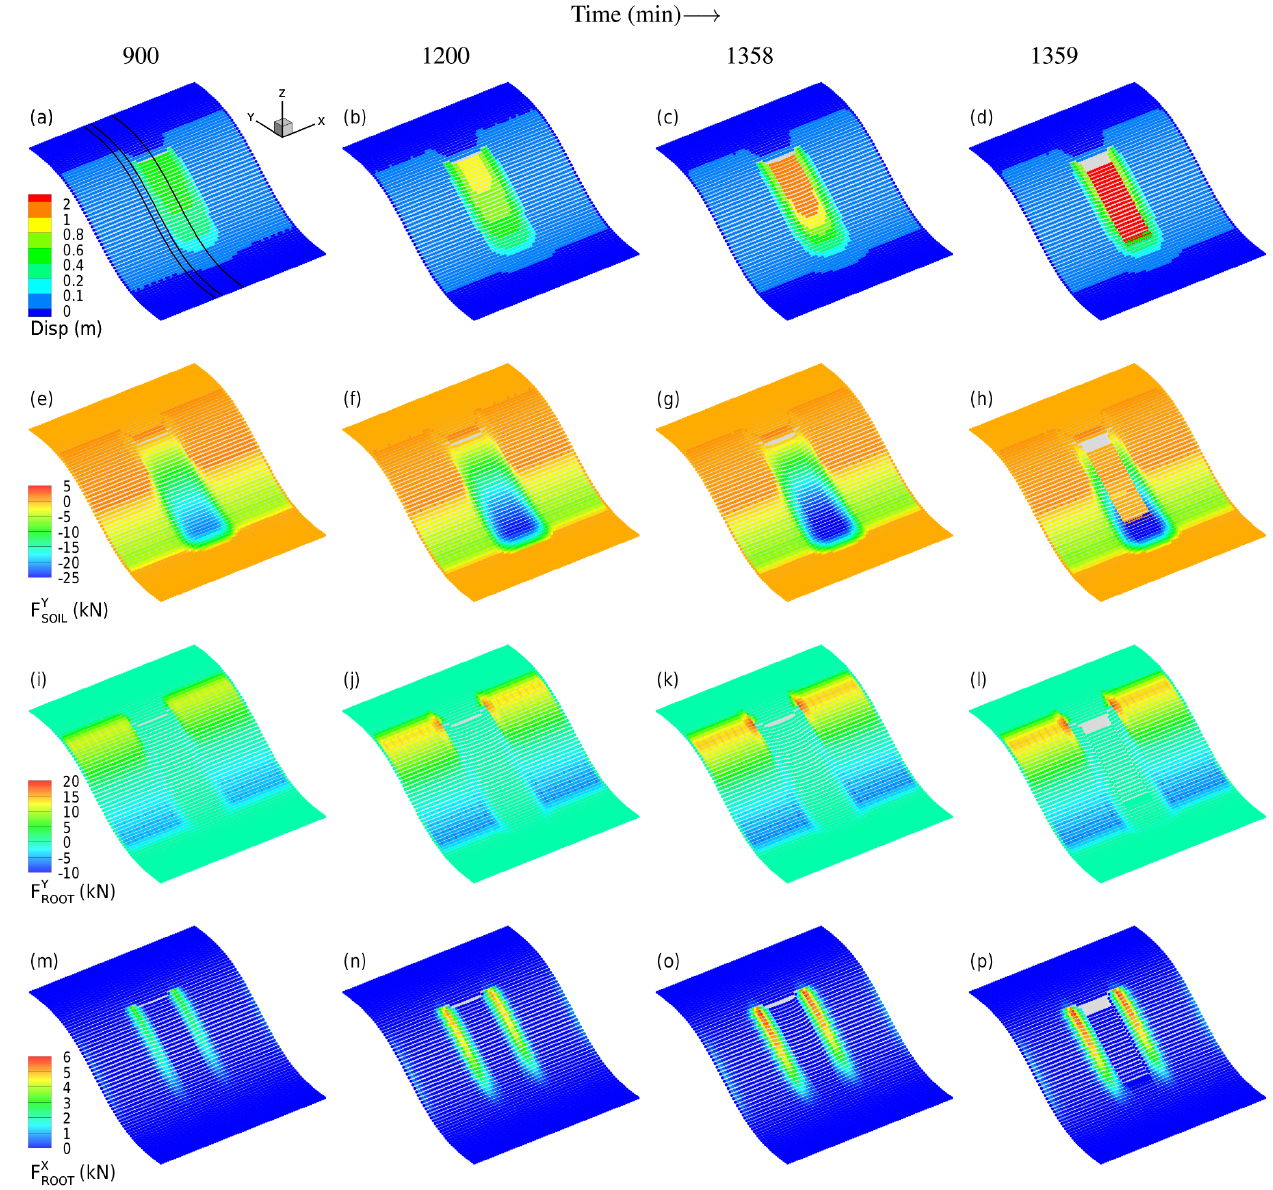
Figure 6. Time evolution of (a–d) total displacement, (e–h) downslope (parallel to steepest slope) soil force, (i–l) downslope root force, and (m–o) across-slope (lateral, also referred to as slope-parallel) root force shown at four time steps (left to right) for the slope shown in Fig. 5. Failure occurs at t = 1359min (last column). t = 1358 min is the time step immediately preceding slope failure. Black curves in panel (a) indicate locations of downslope cross sections at x = 0, x = − 9m, and x = − 12m shown in Fig.